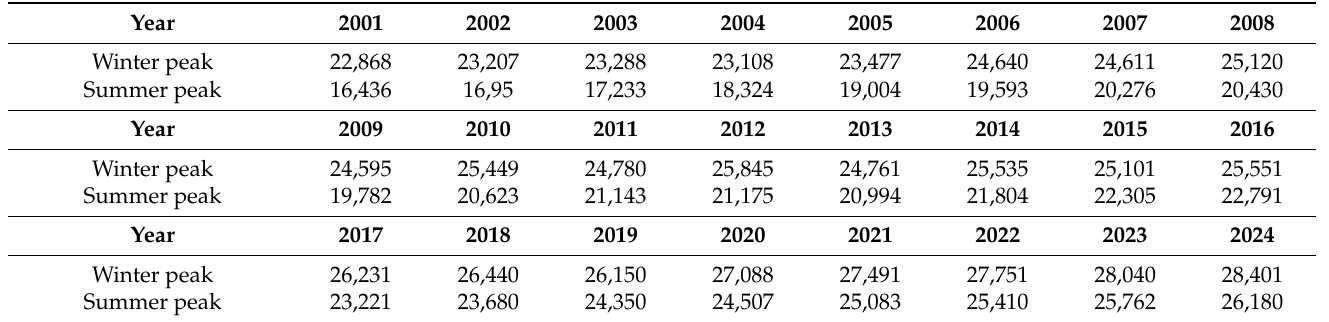
Table 4. Selected energy generators in the National Energy